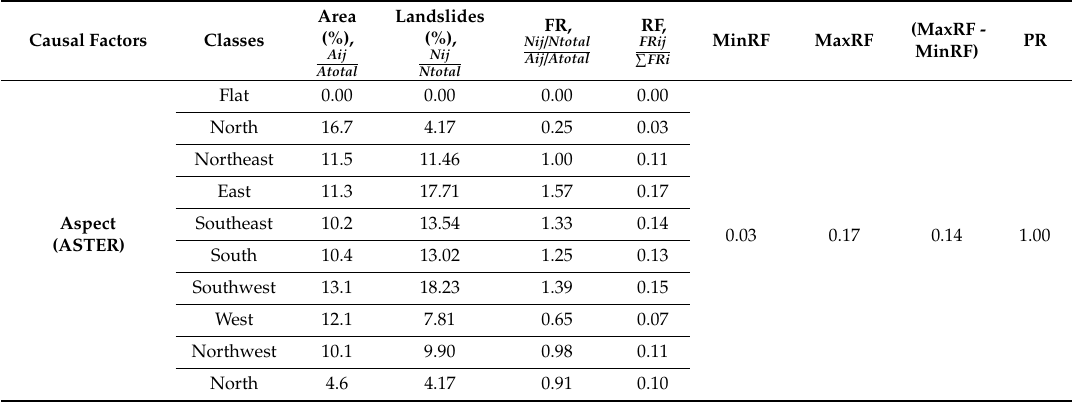
Table A1. Spatial relationship between Causal Factors and Landslides.ASTER DEM; B = SRTM DEM; C = ALOS PALSAR DEM D = SOB